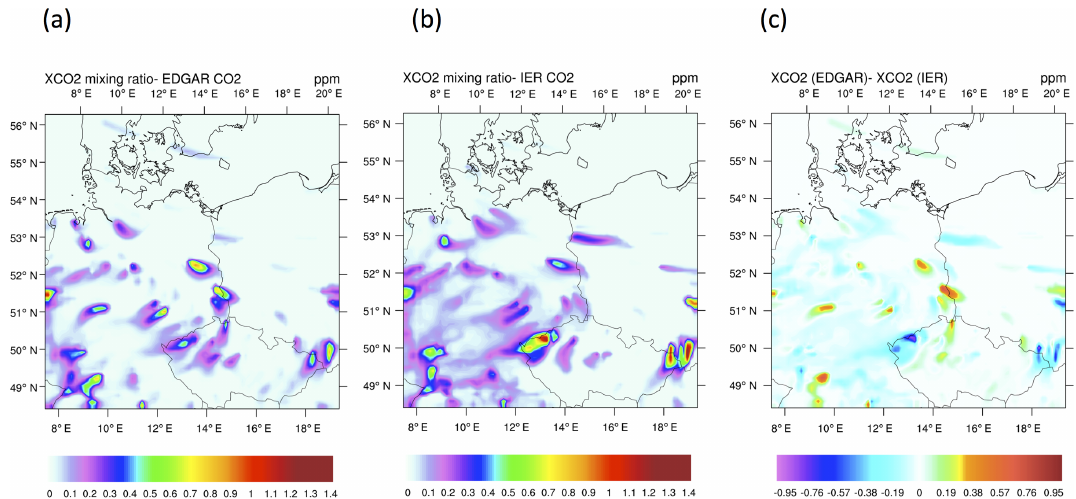
Figure 4. Anthropogenic XCO 2 enhancement on 24 June 2008 at 10:00UTC (local time: 12:00CEST). Panel (a) shows the true XCO 2 enhancement (using EDGAR emissions), and (b) XCO 2 enhancement when using IER emissions. Panel (c) shows the discrepancy in XCO 2 enhancement due to the difference between EDGAR and IER emission inventories. All units are given in